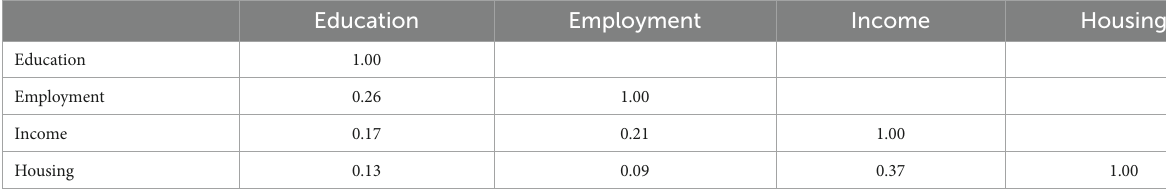
TABLE 2 Spearman rank correlations and significance values for predictor